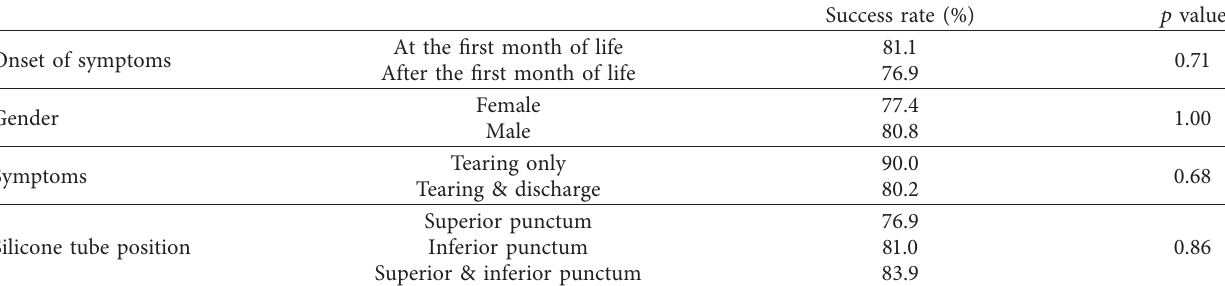
Data are given as mean ± SD or absolute numbers (and proportions). Table 2: Success rates among patients who underwent surgery for nasolacrimal duct obstruction.